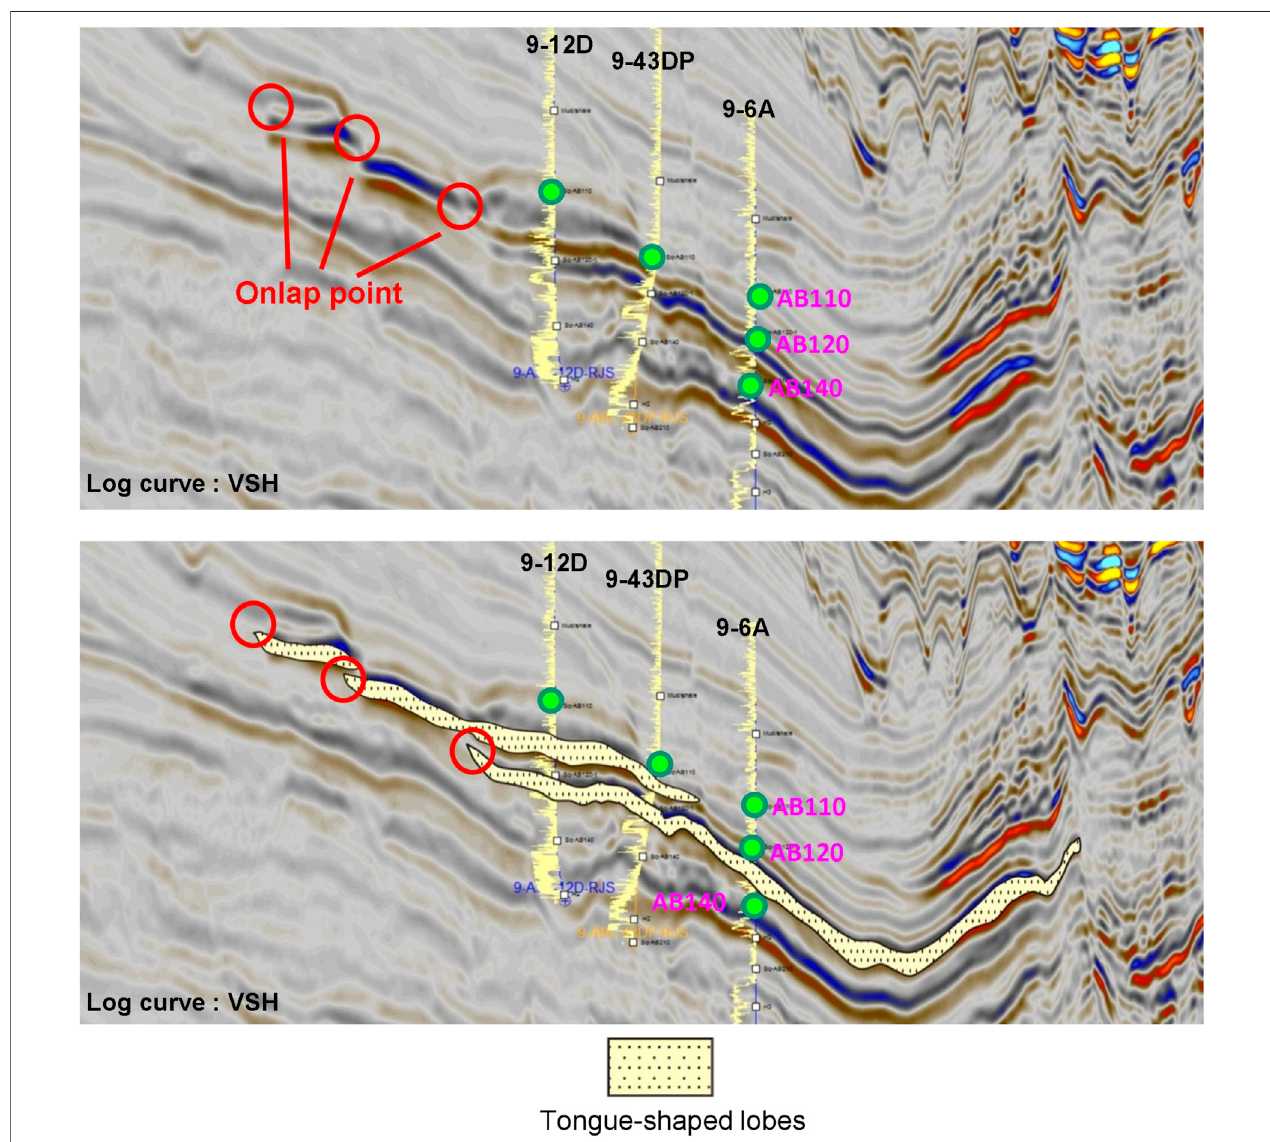
FIGURE 6 | Well seismic pro fi le along the source direction of AB110 — AB120 reservoir.